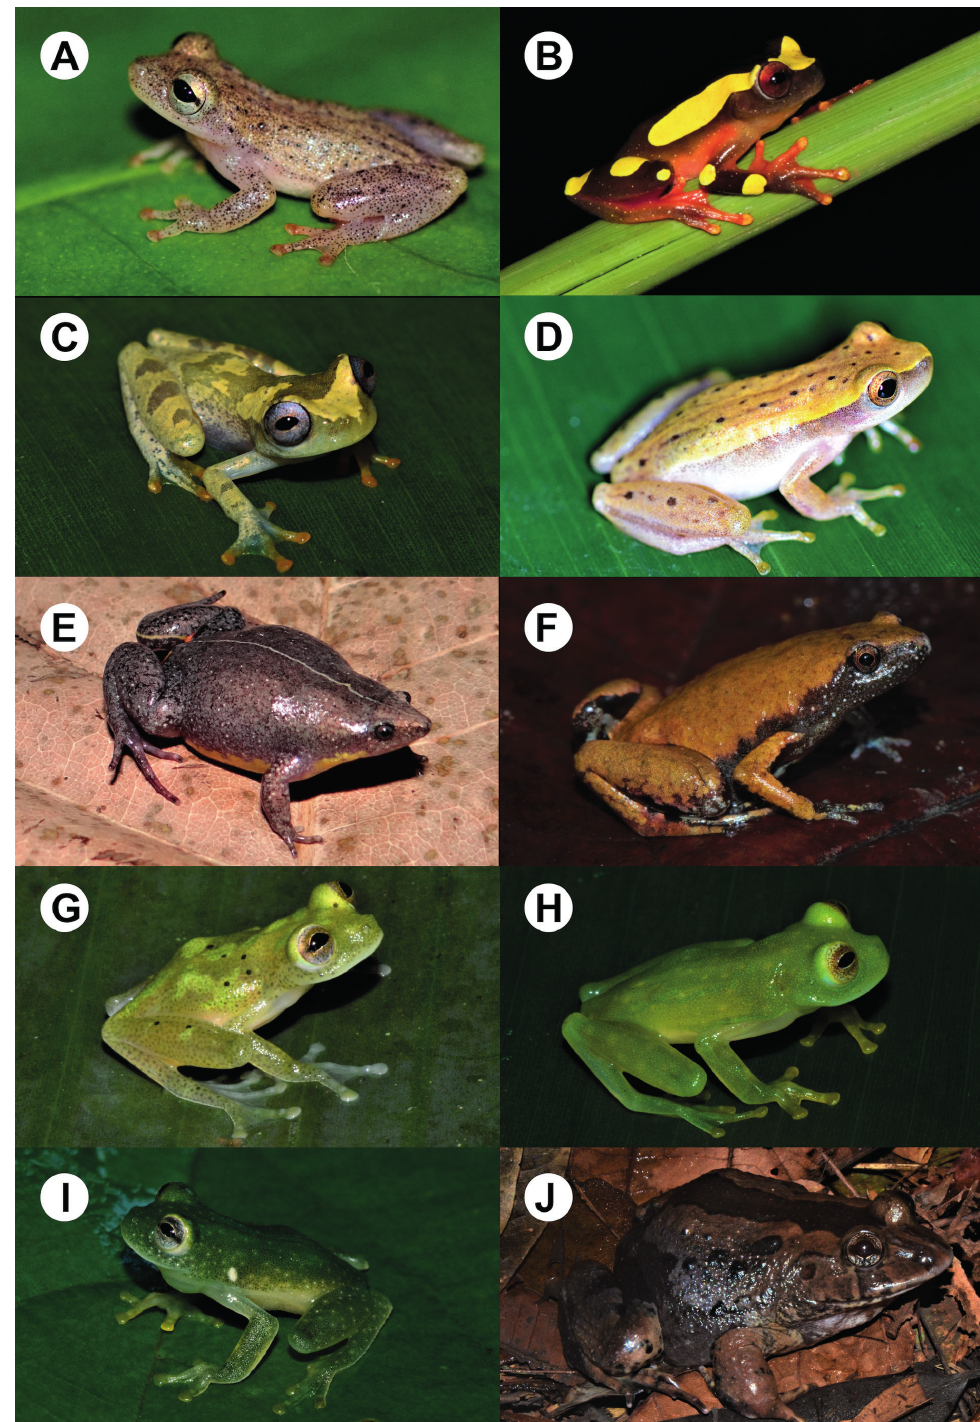
Fig. 4. Anuran species recorded in the state of Amapá. A . Dendropsophus haraldschultzi (Bokermann, 1962). B . Dendropsophus leucophyllatus (Beireis, 1783). C . Dendropsophus minusculus (Rivero, 1971). D . Dendropsophus walfordi (Bokermann, 1962). E . Elachistocleis heliannae Caramaschi, 2010. F . Hamptophryne boliviana Parker, 1927. G . Hyalinobatrachium iaspidiense (Ayarzagüena, 1992). H . Hyalinobatrachium mondolfii Señaris & Ayarzagüena, 2001. I . Hyalinobatrachium taylori (Goin, 1968). J . Hydrolaetare schmidti (Cochran & Goin, 1959) . Photos: C.E.